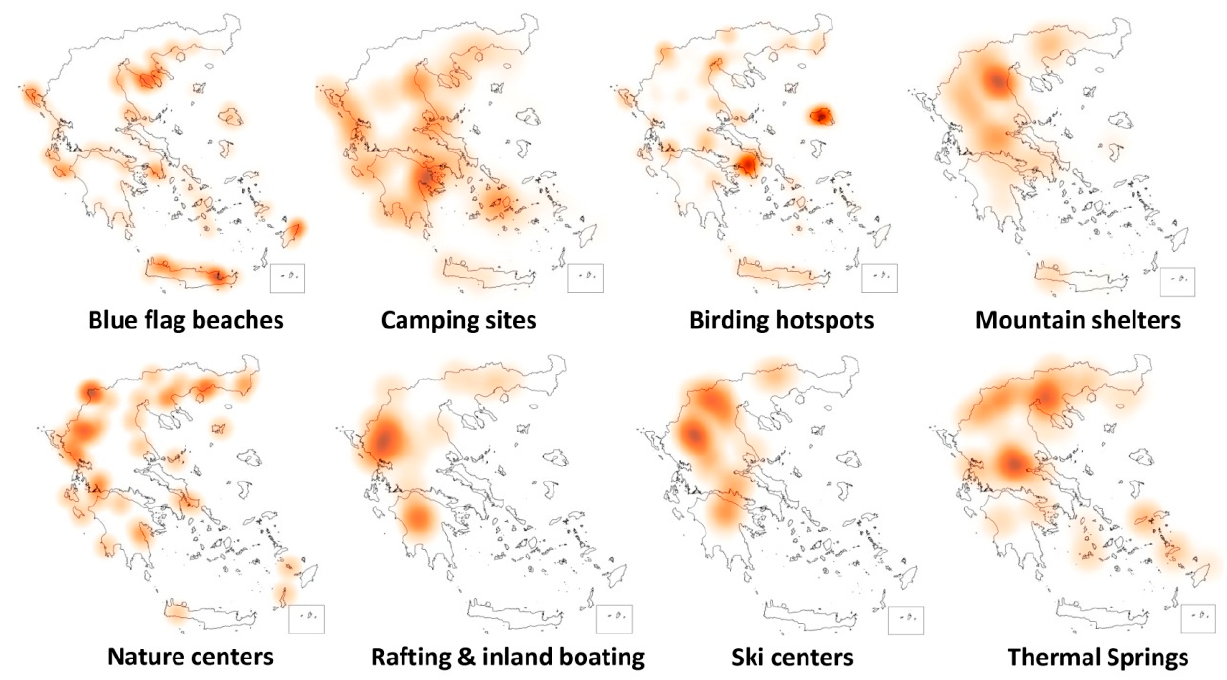
Figure 3. Example of heat maps providing generalization of selected proxy indicators.